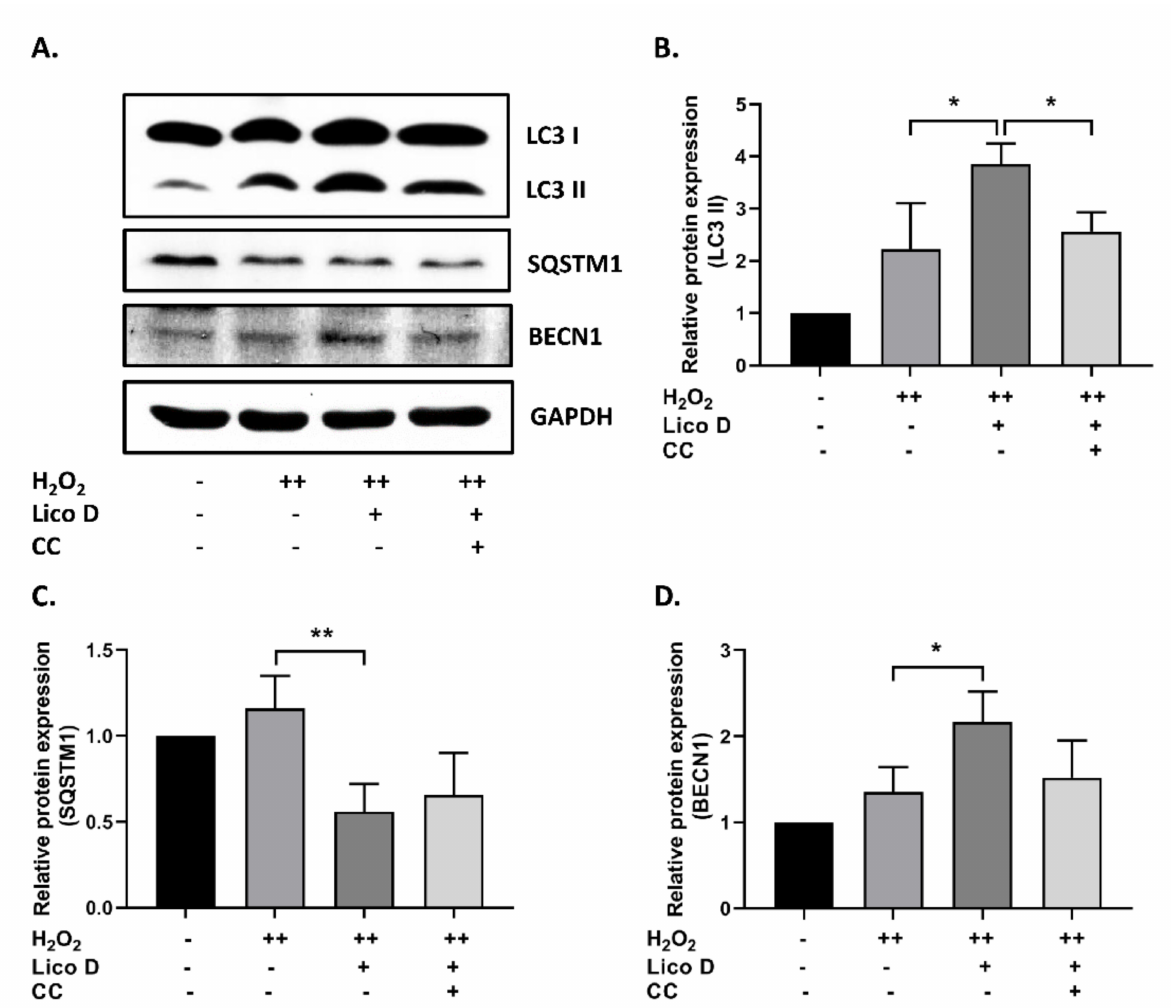
Figure 4. AMPK activation increases the autophagy in oxidative stress induced senescent hBM-MSCs. ( A ) Representative images from immunoblot against autophagy markers including LC3 II, BECN1, and SQSTM1. ( B – D ) The expression level of target proteins was quantified using Image J software. GAPDH was used as an internal control. Compound C (CC), an AMPK inhibitor was used. The results are represented as mean ± SD ( n = 3). * p < 0.05 and ** p <